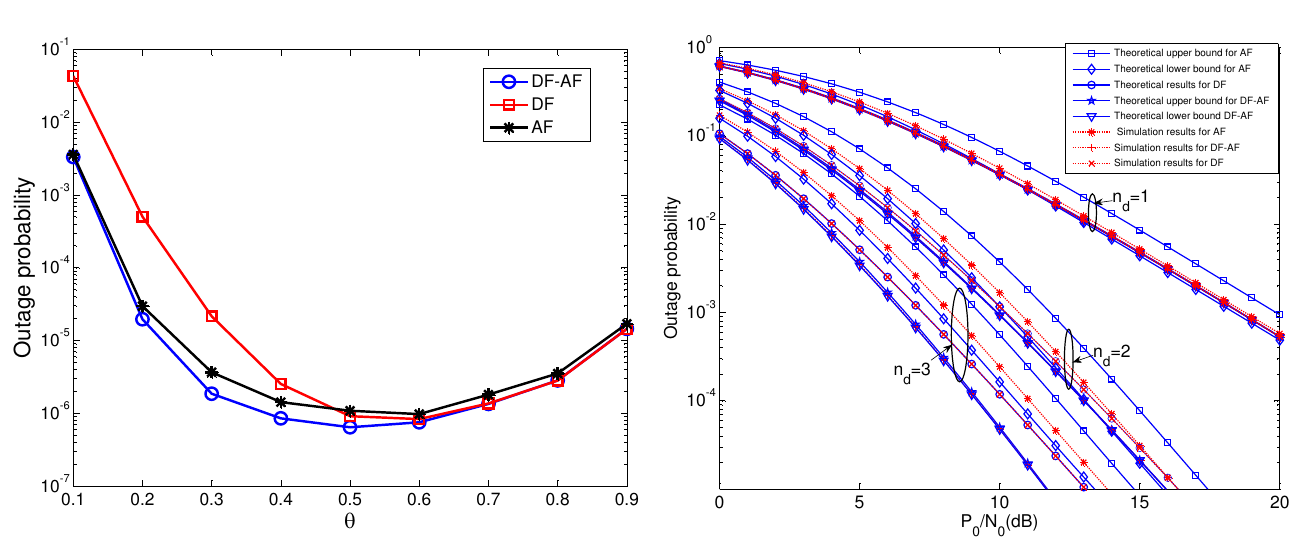
Figure 5. Outage performance of DF-AF selection MIMO relaying, DF MIMO relaying, and AF MIMO relaying with n d = 2 and P = 10 dB .